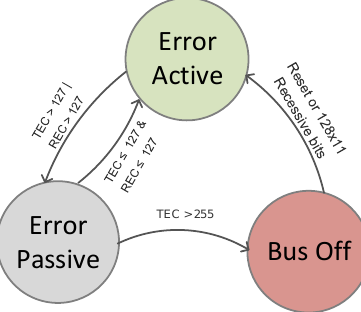
Figure 4. The state diagram of the error confinement mechanism (ECM) in the CAN bus.